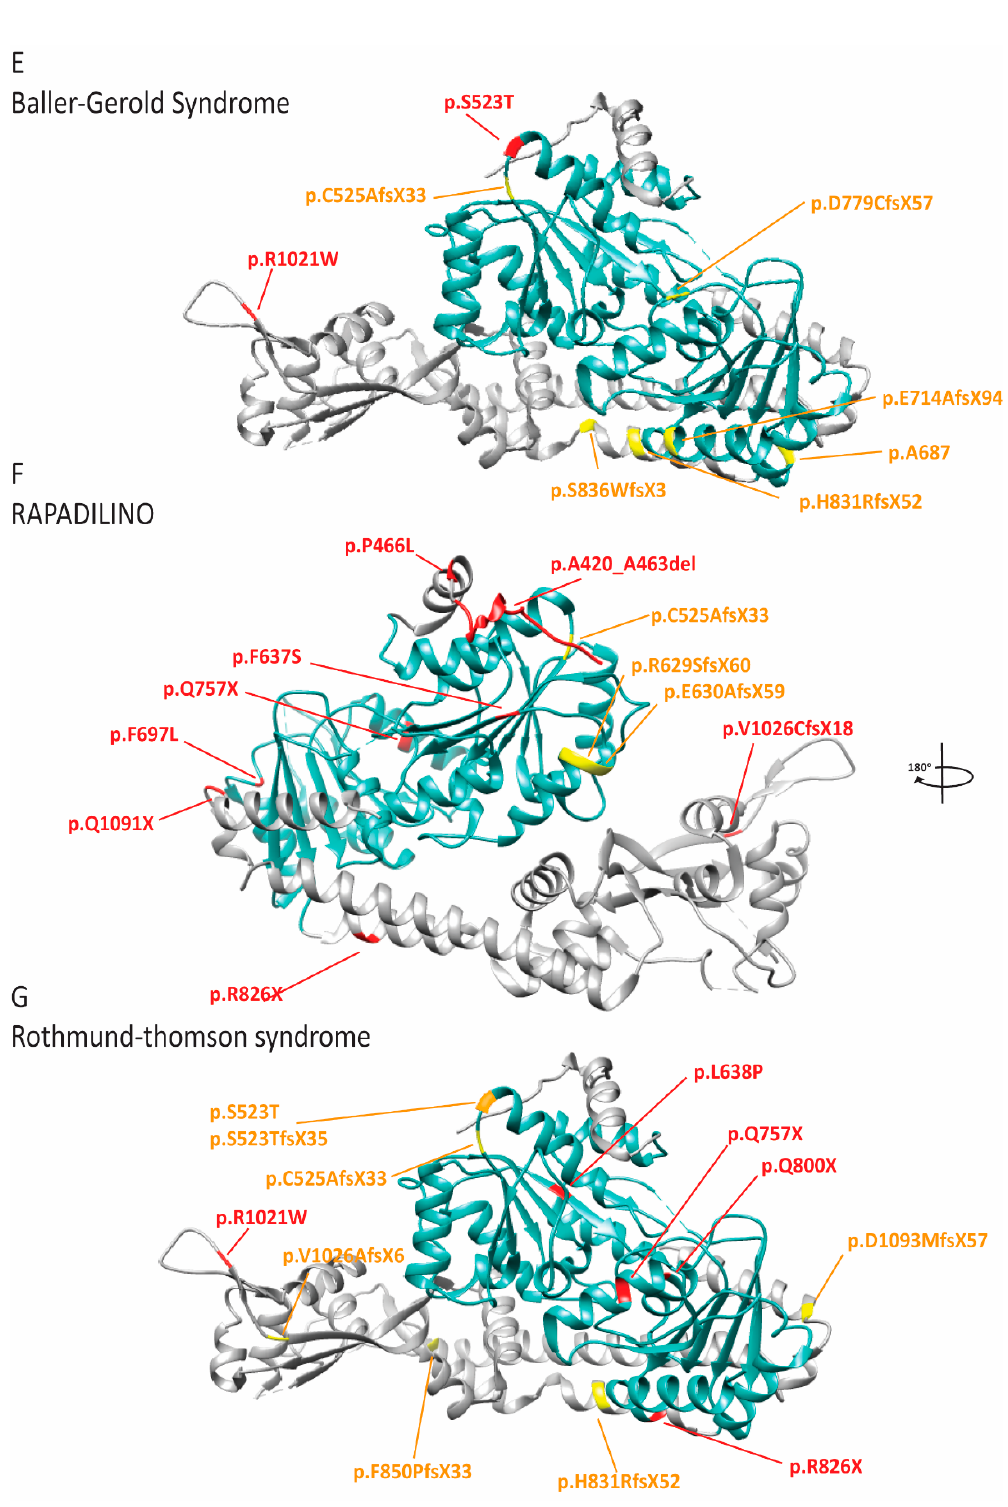
Figure 12. Pathogenic variants in RECQL4 are associated with three different syndromes, Rothmund – Thomson (RTS), Baller – Gerold (BGS) and RAPADILINO (RAdial hy-po/aplasia, PAellae hypo/aplasia and cleft PAlate, DIarrhea and DIslocated joint, LIttle size and LImb malformation, NOse slender and NOrmal intelligence). Mutations of RECQL4 in BGS, RAPADILINO and RTS are depicted on a schematic of the gene and crystal structure of Homo sapiens RECQL4. For a complete list of mutations and associated protein changes, see Supplementary Table S1. The structure was generated using pdb file 5lst and the Chimera program (http://www.cgl.ucsf.edu/chimera). Exon and intron schematics were generated with the UCSD genome browser. Reference sequence is RECQL4 NM_004260.4. Schematic of RECQL4 gene for ( A ) BGS and ( B ) RAPADILINO is depicted with exons as black boxes and introns as horizontal lines. Mutations are mapped to the appropriate gene regions. “H” superscript indicates a homozygous mutation. Compound heterozygous